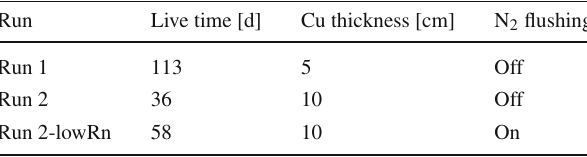
Table 1 Runs setup details including live